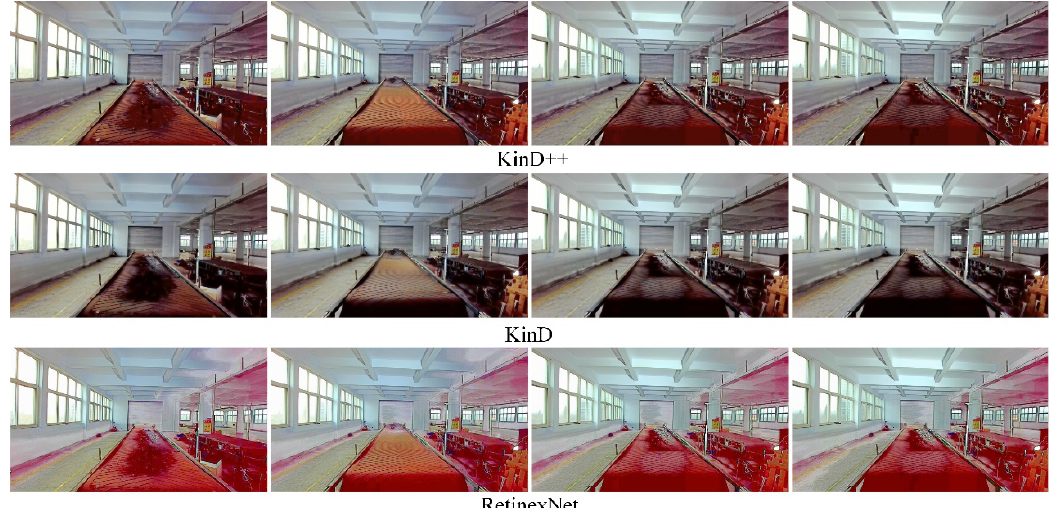
Figure 16. Enhancement of images with light sources in the evening by deep learning algorithm.